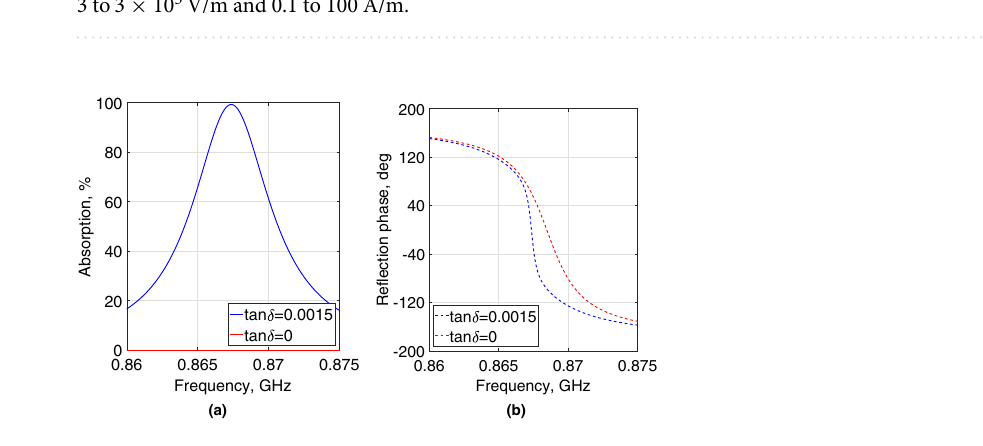
Figure 4. Simulated absorption ( a ) and reflection phase ( b ) of the proposed unit-cell with tan δ equal to 0.0015 and 0 for a normal incident